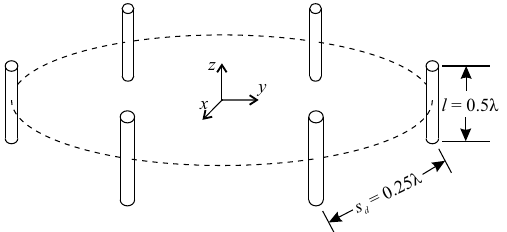
Figure 4. Uniform and circular array (UCA) with six dipoles, where l is the dipole length and s d is the distance between dipoles.